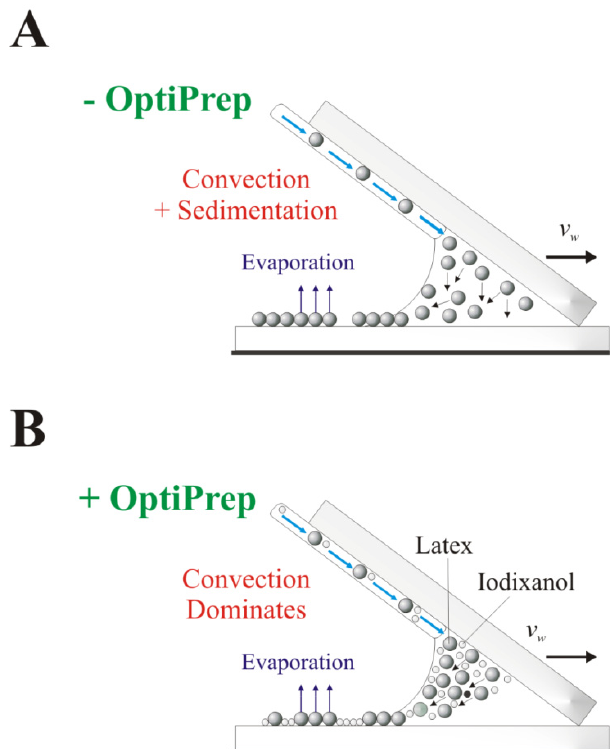
Figure 3. Schematic of the proposed variation in coating assembly when suspension fluid density is modified. ( A ) Aqueous particle suspension process. The particles disperse throughout the meniscus; ( B ) OptiPrep TM -medium with increased fluid density, altering the convective assembly mechanism by delaying particle incorporation into the